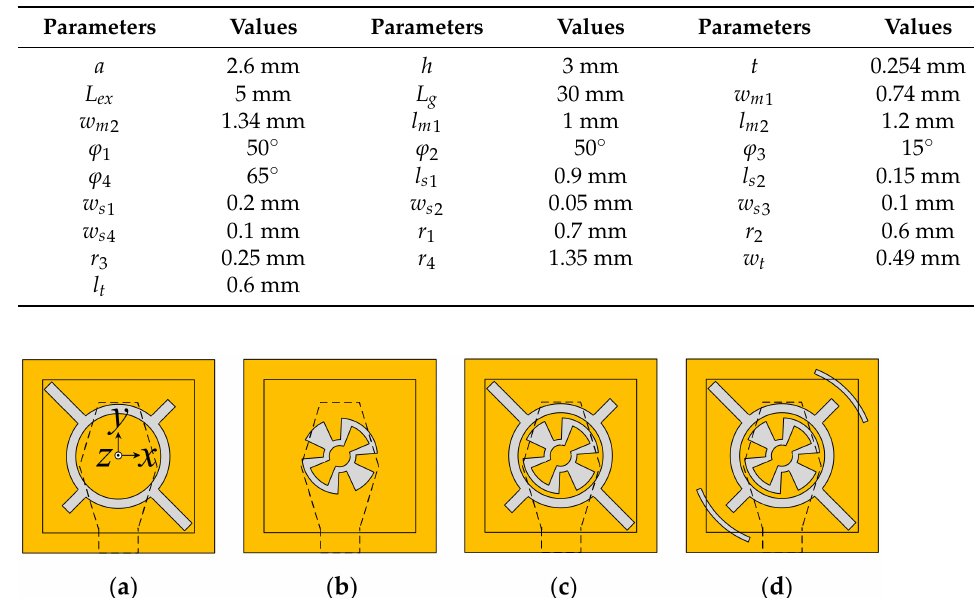
Figure 2. Configurations of three reference antennas and the proposed antenna: ( a ) Antenna 1: the DRA fed by Slot 1; ( b ) Antenna 2: the DRA fed by Slot 2; ( c ) Antenna 3: the DRA fed by Slot 1 and 2; ( d ) Antenna 4: the proposed antenna.